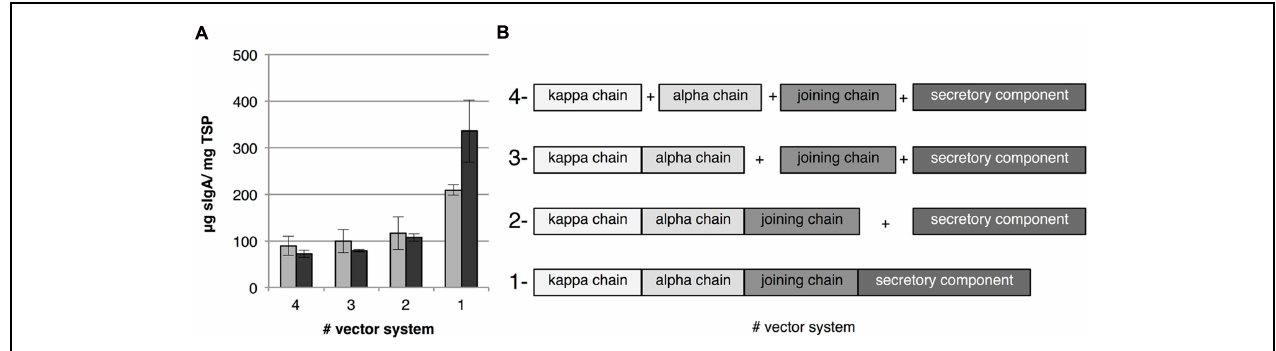
FIGURE 3 | sIgA yield upon transient transformation using co-infiltration and multi-cassette vectors. (A) Average sIgA yield 6 dpi of three biological replicates in leaf extracts when co-infiltrating all genes individually, co-infiltrating the secretory component and joining chain with the multi-cassette vector for IgA1 κ expression, co-infiltrating the secretory component and the multi-cassette vector for dIgA expression and the infiltration of the multi-cassette vector for sIgA expression indicated as the 4-, 3-, 2-, and 1-vector system, respectively. The final OD of the infiltration mix was set to 2.5 using either an Agrobacterium culture carrying an EV (light gray bars) or the OD of the Agrobacterium culture carrying the multi-cassette vector was increased (dark gray bars). Error bars indicate standard error. (B) A schematic overview of the expression cassettes in the 4-, 3-, 2-, and 1-vector systems.